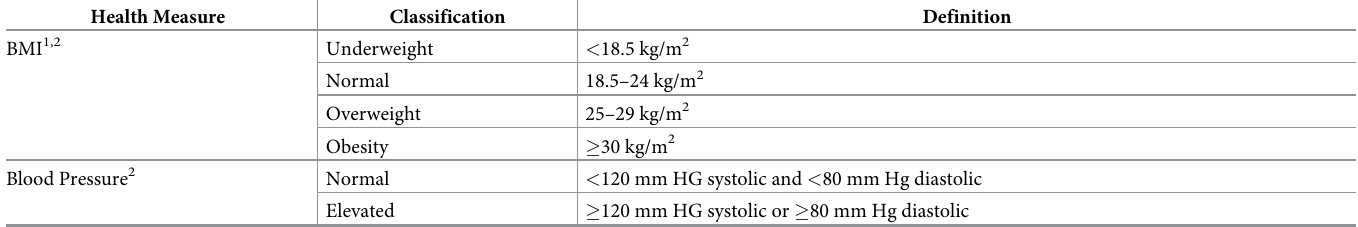
Table 1. Classification of health assessment components reported at Texas domestic medical screening examination of Cuban entrants, 2010–2015. Health